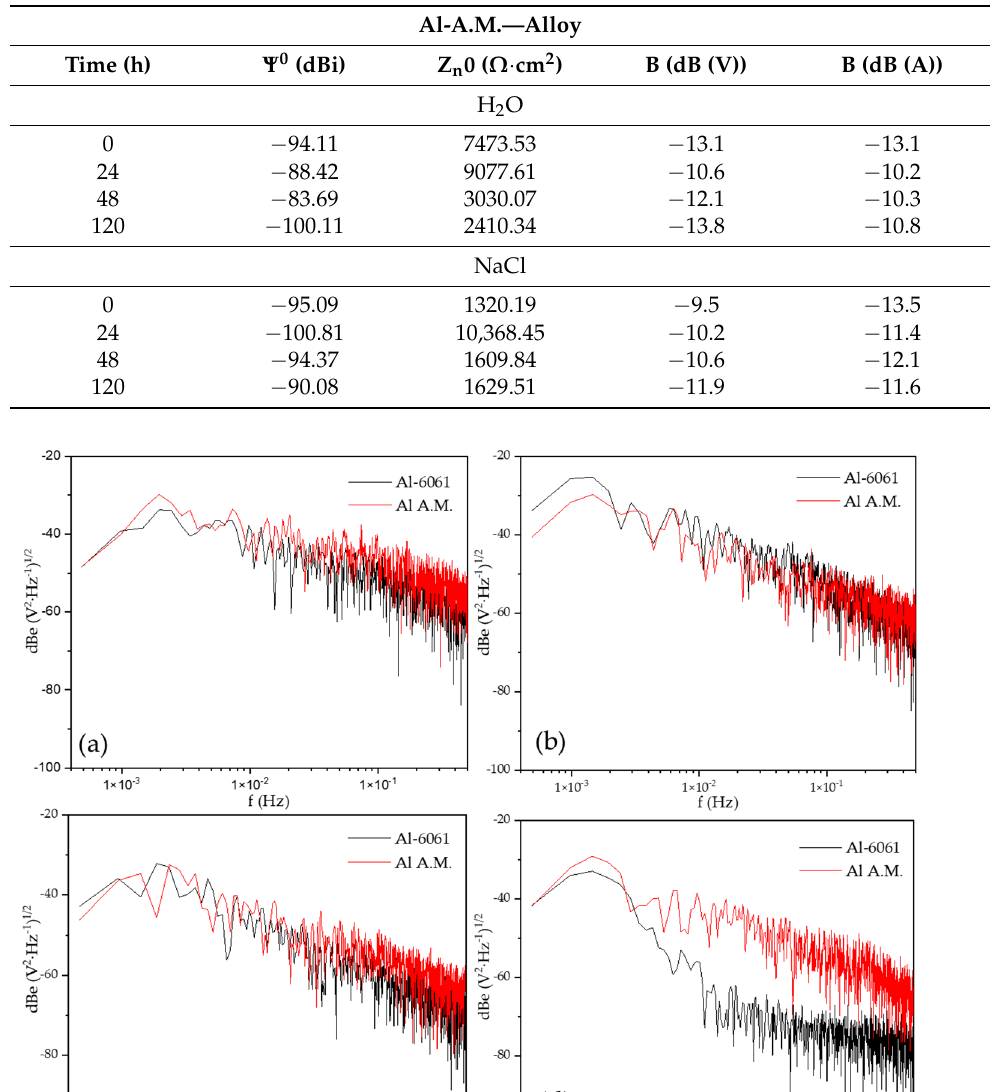
Figure 9. Power spectral density (PSD) in current in NaCl solution, ( a ) 0 h, ( b ) 24 h, ( c ) 48 h, and ( d ) 120 h.